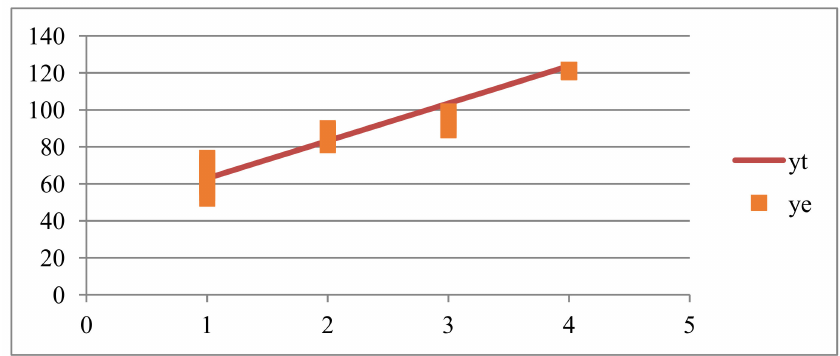
Figure 6. Diagram of linear regression of the particulate parameter for mixture